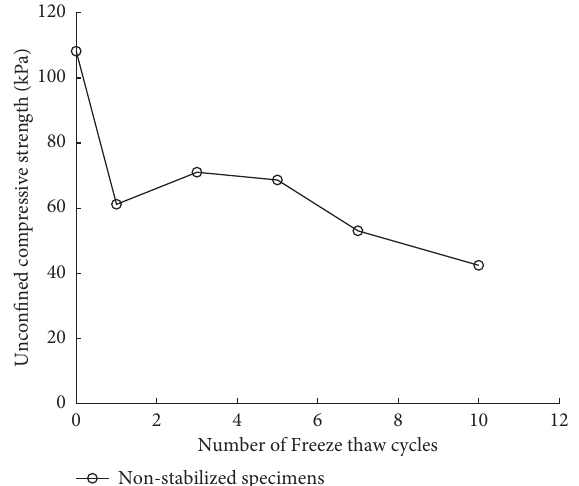
Figure 17: Changes of unconfined compressive strength of nonstabilized specimens with freeze-thaw